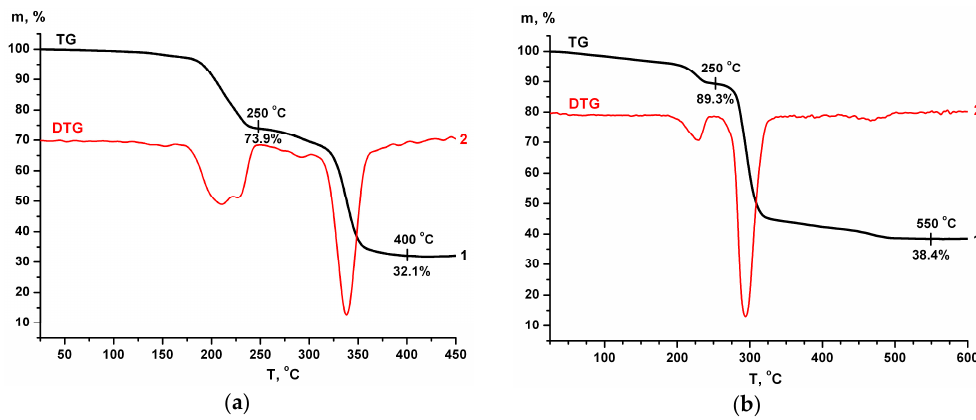
Figure 6. Curves of thermal analysis for compound 1 ( a ) and for compound 2 ( b ).